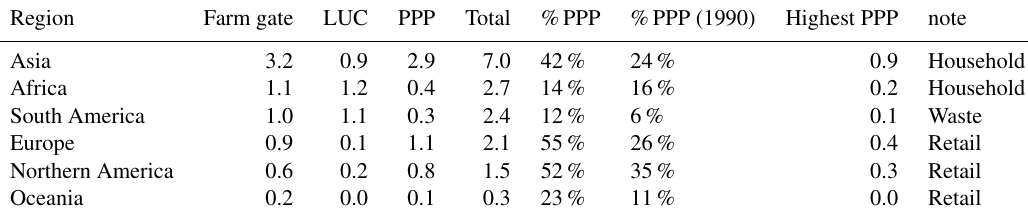
Table 2. Regional GHG emissions (GtCO 2 eq.) by agri-food system component, showing farm gate, land use change (LUC), pre- and post- production processes (PPPs), and total emissions percentage contribution of PPPs shown for the year 1990 and 2019. The last two columns show the largest estimated contributing PPP activity by region. Uncertainties are estimated to be 30% for farm gate and PPP activities and 50% for land use change. Region Farm gate LUC PPP Total %PPP %PPP (1990) Highest PPP note Asia